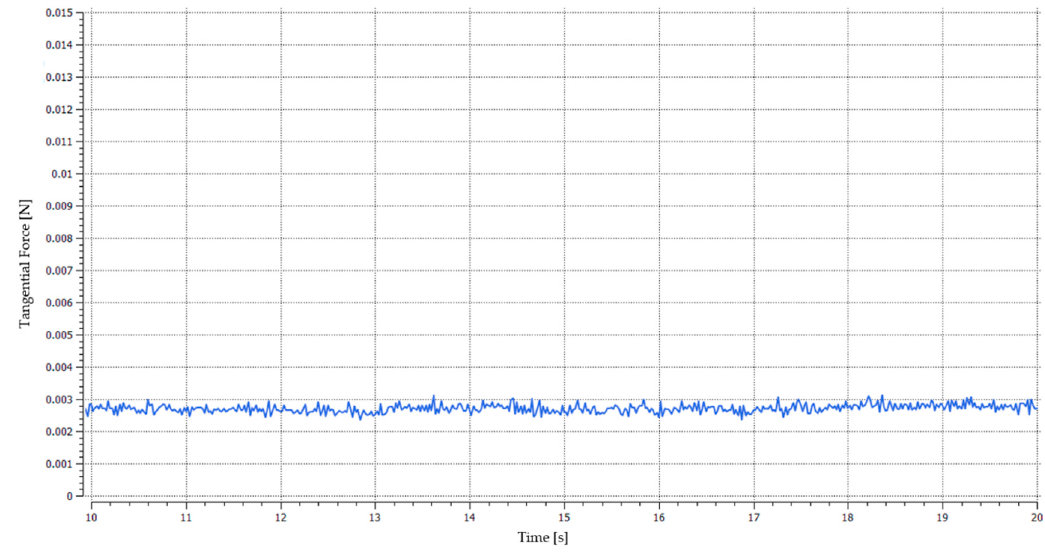
Figure 12. Standard deviation of the average force acting on the fruit in the tangential direction reciprocating transport.